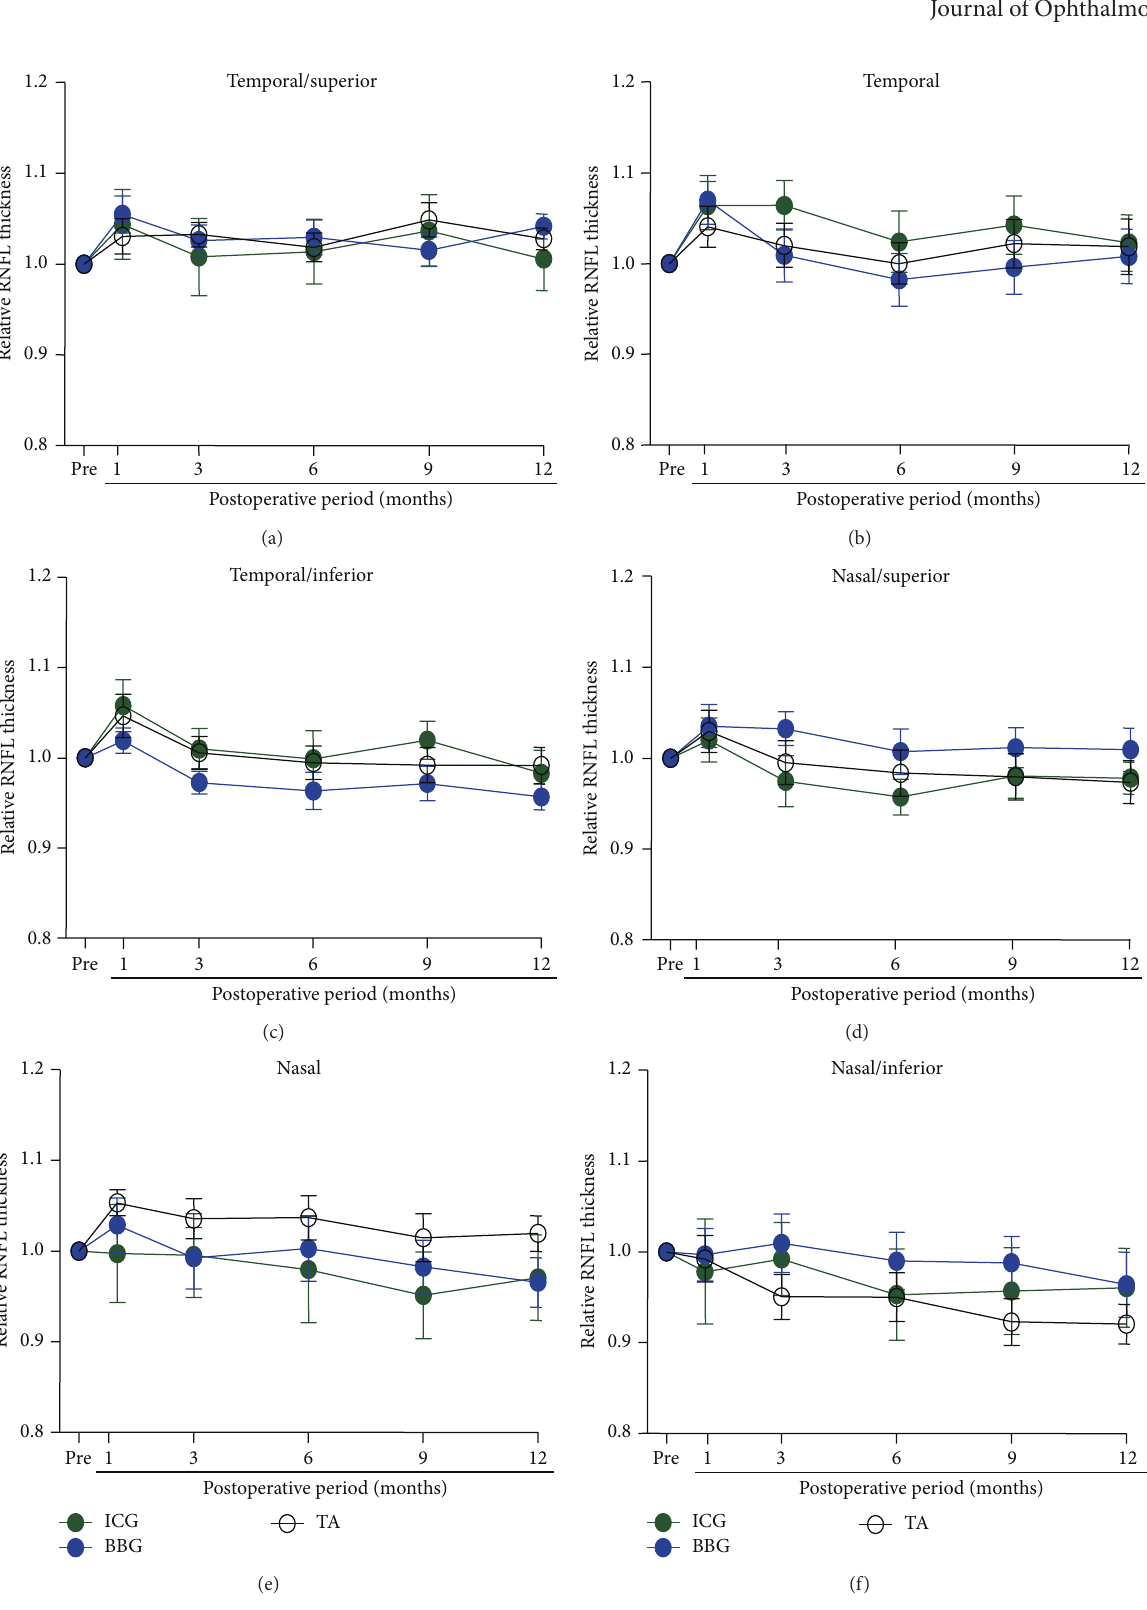
Figure 3: Means of the relative RNFL thickness are plotted as a function of postoperative periods for the temporal/superior (a), temporal (b), temporal/inferior (c), nasal/superior (d), nasal (e), and nasal/inferior (f) sector analyses. The RNFL thickness is expressed relative to the preoperative value. Green, blue, and black symbols represent ICG, BBG, and TA groups, respectively. Means ± SEMs. RNFL: retinal nerve fiber layer, ICG: indocyanine green, BBG: brilliant blue G, TA: triamcinolone